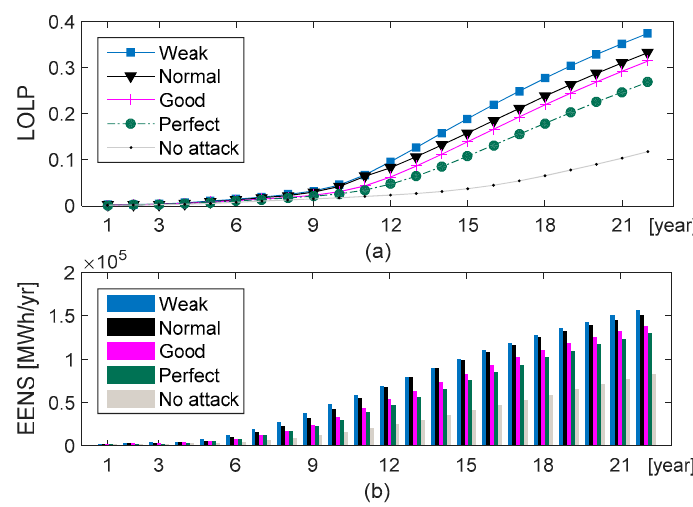
Figure 11. Reliability indices of system attacked by an imperfect attack (IPA). ( a ) LOLP; ( b )